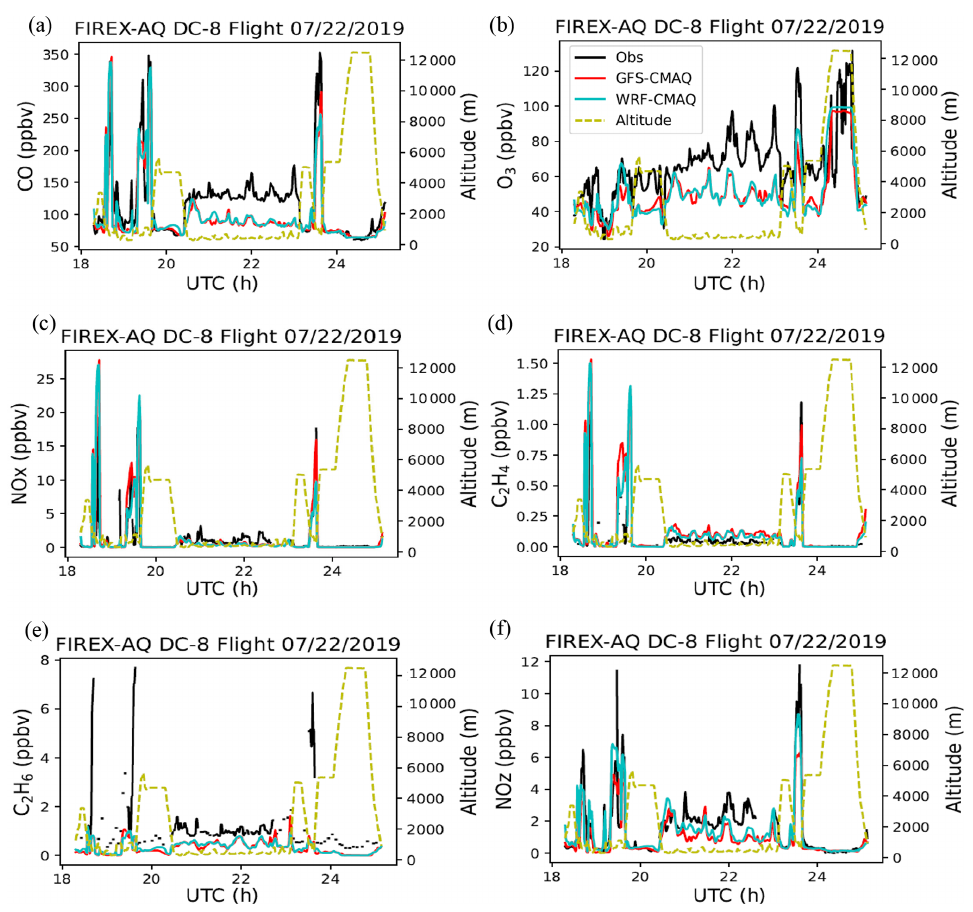
Figure 9. Model-predicted chemical concentrations compared with observations along with the DC-8 flight on 22 July